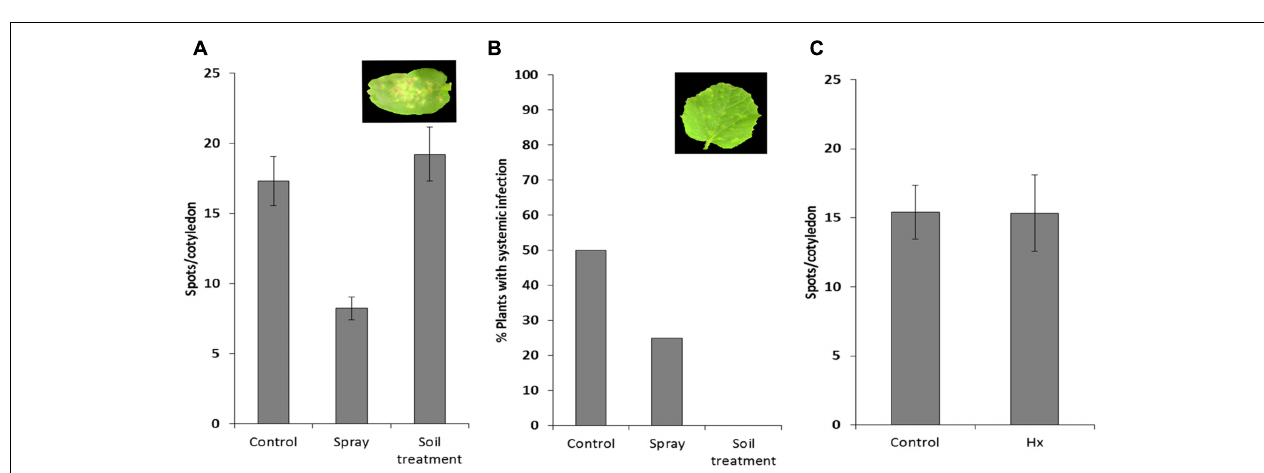
FIGURE 2 | Effect of hexanoic acid on melon plants infected with MNSV. The 1-week-old melon plants were treated with 25 mM of Hx by spray or by soil drench, and were subsequently infected mechanically with the MNSV-Al isolate. Treatments were applied 72 and 24 h before MNSV inoculation, with an additional application 24 h after inoculation. Infection severity was expressed as the number of spots per cotyledon at 5 dpi (A) and by counting the number of plants with systemic symptoms at 18 dpi (B) Data show a representative experiment repeated three times with similar results. The 1-week-old melon plants were treated with 25 mM Hx, applied by soil drench at 72 and 24 h before MNSV inoculation. Infection severity was expressed as the number of spots per cotyledon at 5 dpi (C) . Data show the average of three independent experiments of a pool of 10 plants per experiment ±